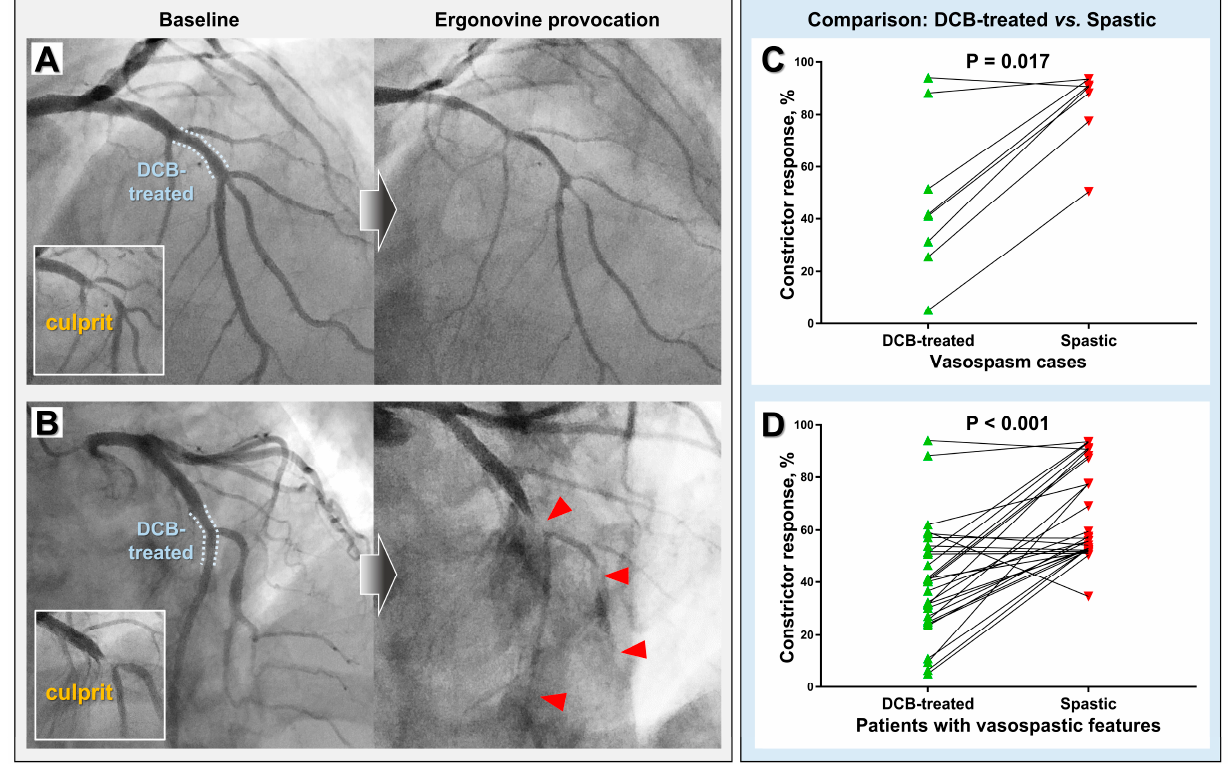
Figure 3. Representative vasospasm cases ( left panel ) and comparison of ergonovine-mediated vasoconstrictive response between DCB-treated and spastic segments ( right panel ). ( A ) A case showing ergonovine-induced spasm that developed diffusely throughout multiple territories while sparing the DCB-treated lesion. ( B ) A case showing multifocal spasm that involved both the DCB- treated lesion and neighboring arterial segments (red arrowheads). Paired comparison results of seven vasospasm cases ( C ) and twenty-nine patients with vasospastic features ( D ). DCB, drug-coated